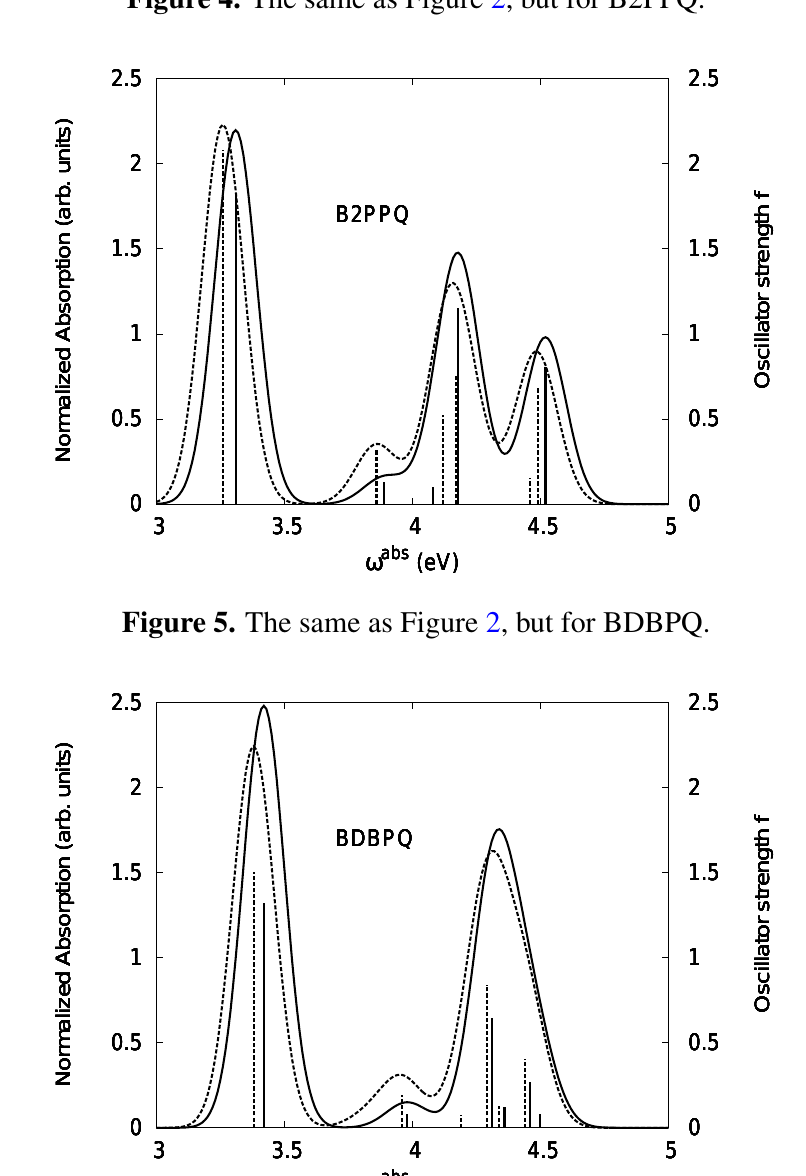
Figure 4. The same as Figure 2, but for B2PPQ.